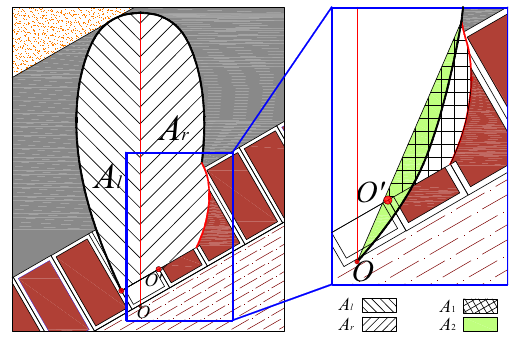
Fig. 16 Volume calculation for the drawing body in an inclined